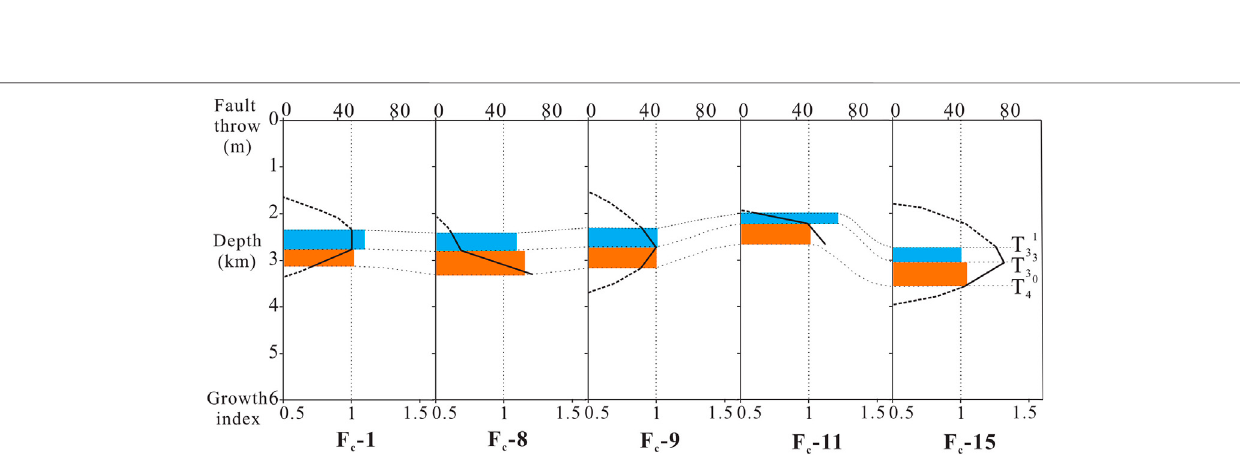
FIGURE 9 | Growth index and ‘ fault throw-depth ’ relationship curve (T-z pro fi le) of long-term active concealed faults. The blue and orange rectangles indicate the growth index, corresponding to the lower coordinate axis. The black polyline indicates the ‘ fault throw-depth ’ relationship curve, corresponding to the upper coordinate